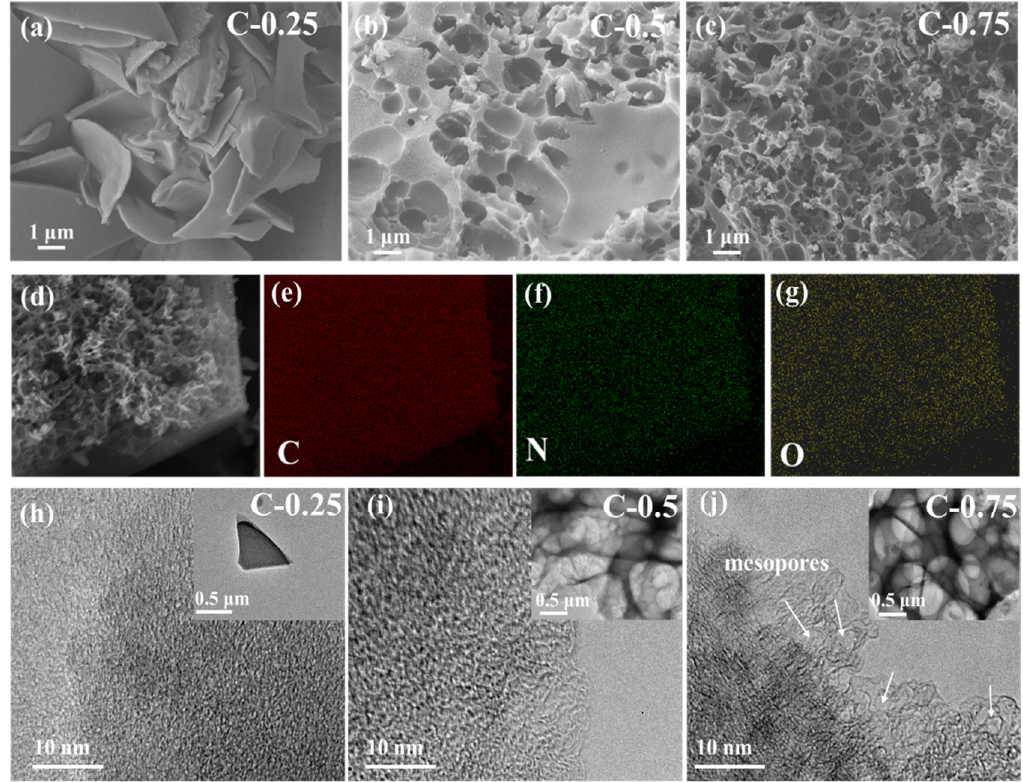
Figure 1. ( a - c ) Scanning electron microscope (SEM)images of the porous carbon. ( d - g ) Energy- Figure 1. ( a – c ) Scanning electron microscope (SEM)images of the porous carbon. ( d – g ) Energy-dispersive dispersive X-ray spectroscopy EDS) mapping of C-0.75 with C, N, and O elements. ( h - j ) Transmission X-ray spectroscopy EDS) mapping of C-0.75 with C, N, and O elements. ( h – j ) Transmission electron electron microscope (TEM) images. microscope (TEM) images. Nanomaterials 2020 , 10 , 353